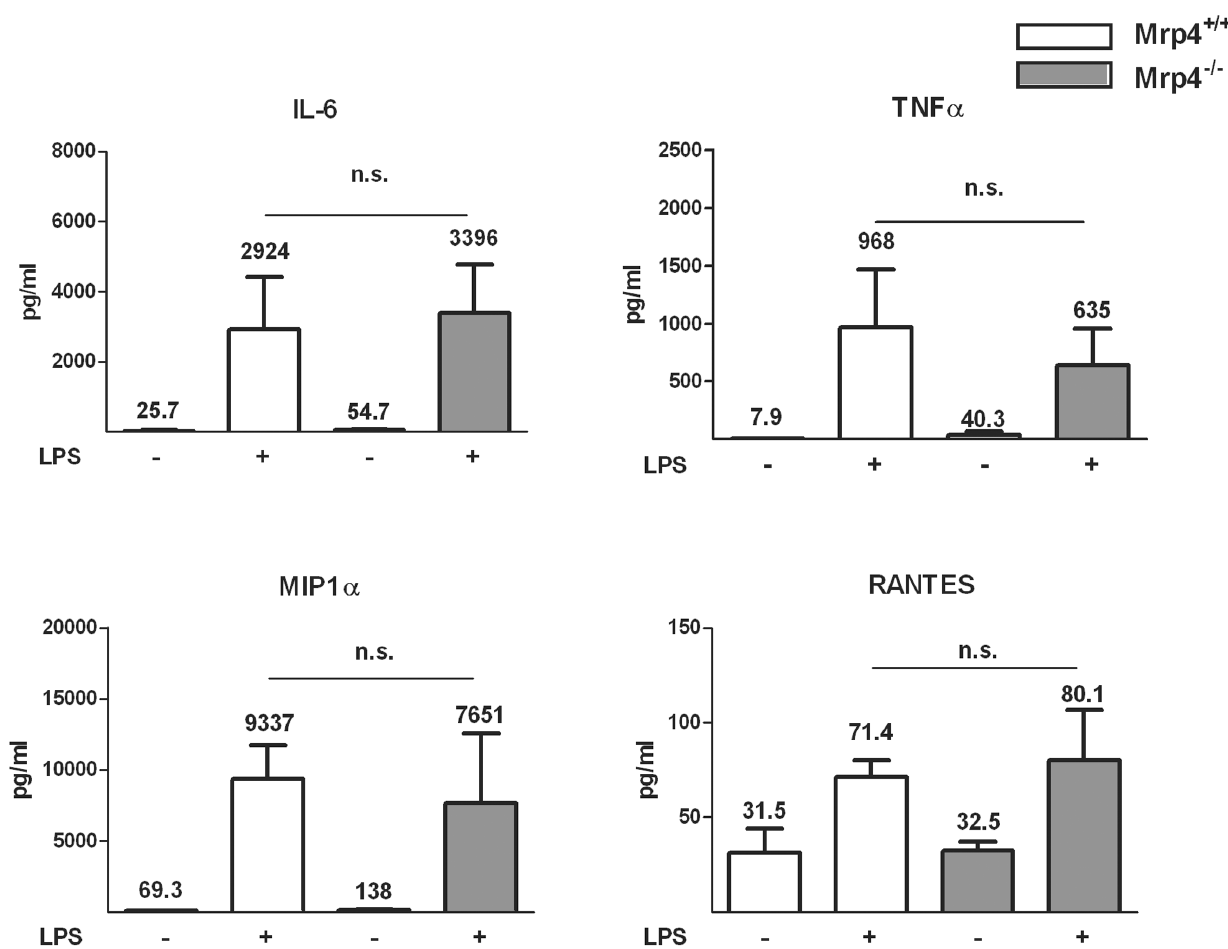
Figure 4. LPS-induced Cytokine release in whole blood was not dependent on Mrp4. Blood samples were collected retro-bulbar from Mrp4 2 / 2 mice (open bars) and Mrp4 + / + mice (grey bars) and treated with LPS ( + ; 600 ng/ml) or PBS for control ( 2 ). After 4 h incubation ex vivo the concentrations of IL-6, TNF a , MIP a , and RANTES were measured in the plasma. n=4–6. * p=0.05. n.s. not significant. Data are mean 6 SEM.